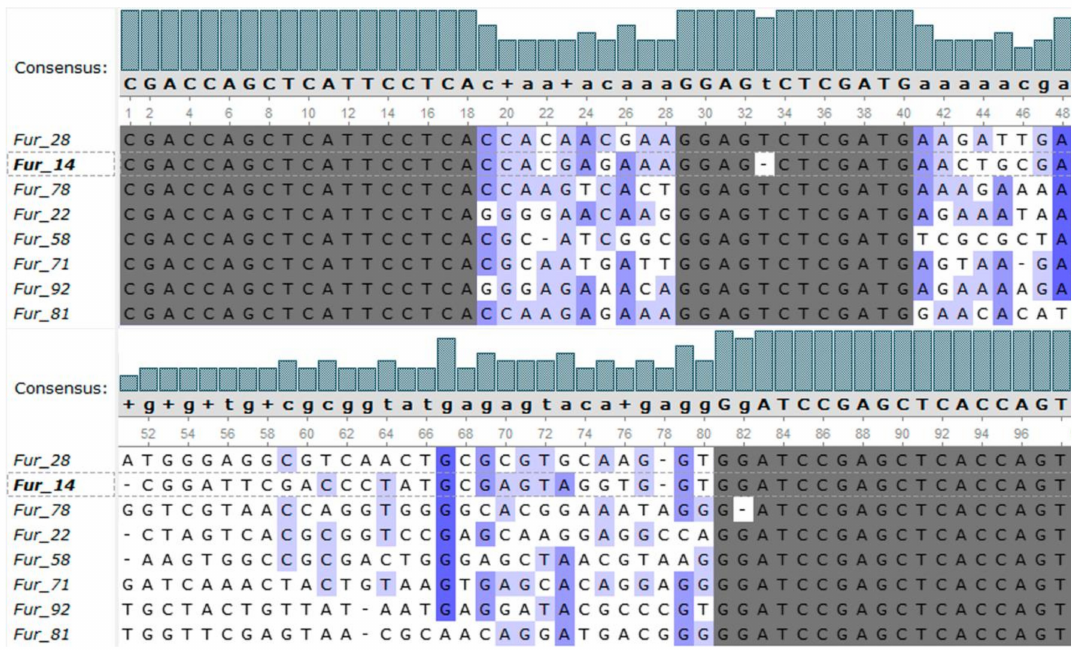
Figure 2. Alignment of the candidate aptamer sequences. Constant regions of the B1_bank library are highlighted in grey. Alignment was performed using Clustal Omega algorithm in the BioEdit software and visualized in the Unipro UGENE